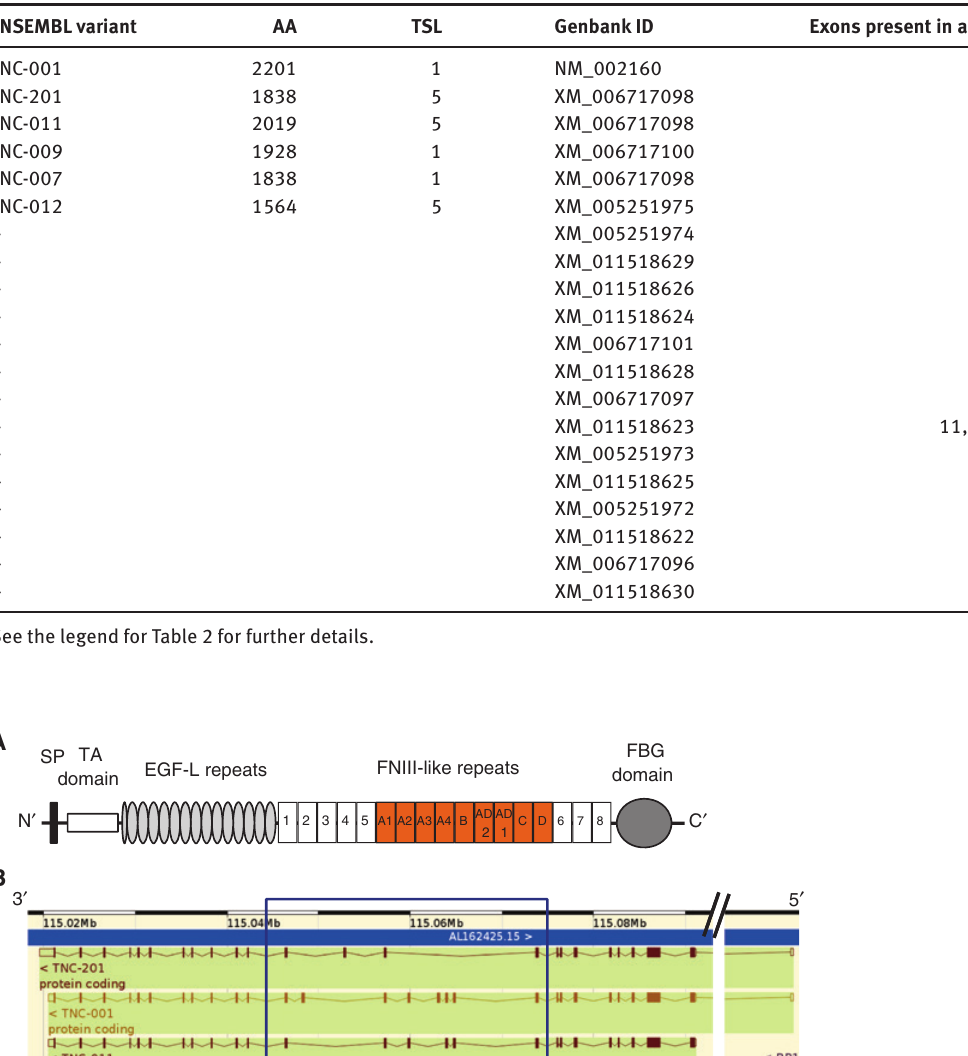
Table 3: Tenascin-C splice variants encoded by the TNC gene.